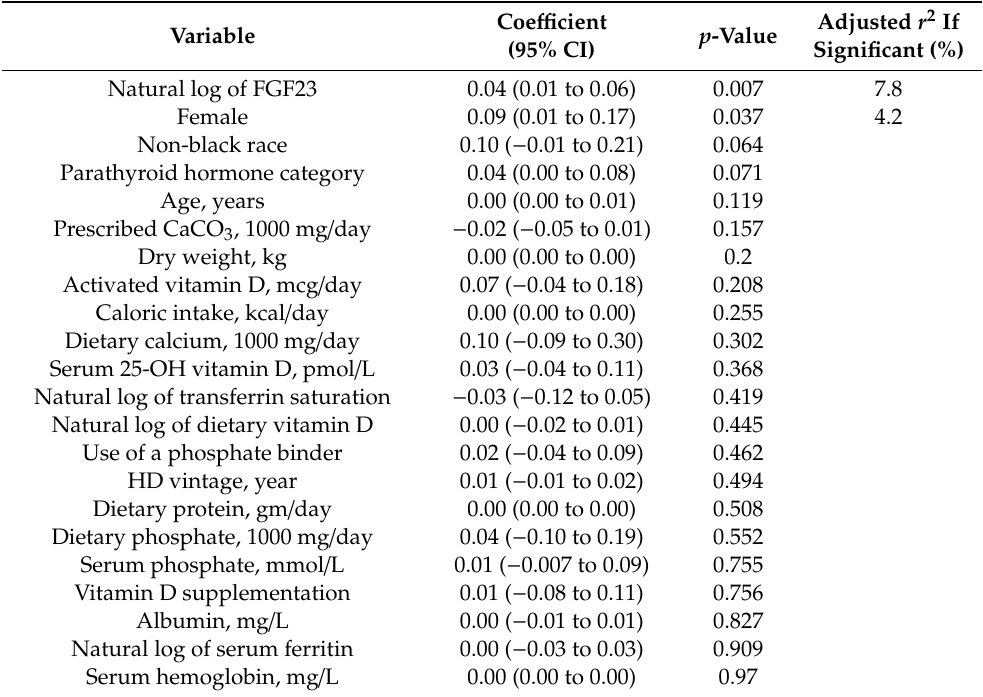
Table 2. Bivariable associations of serum